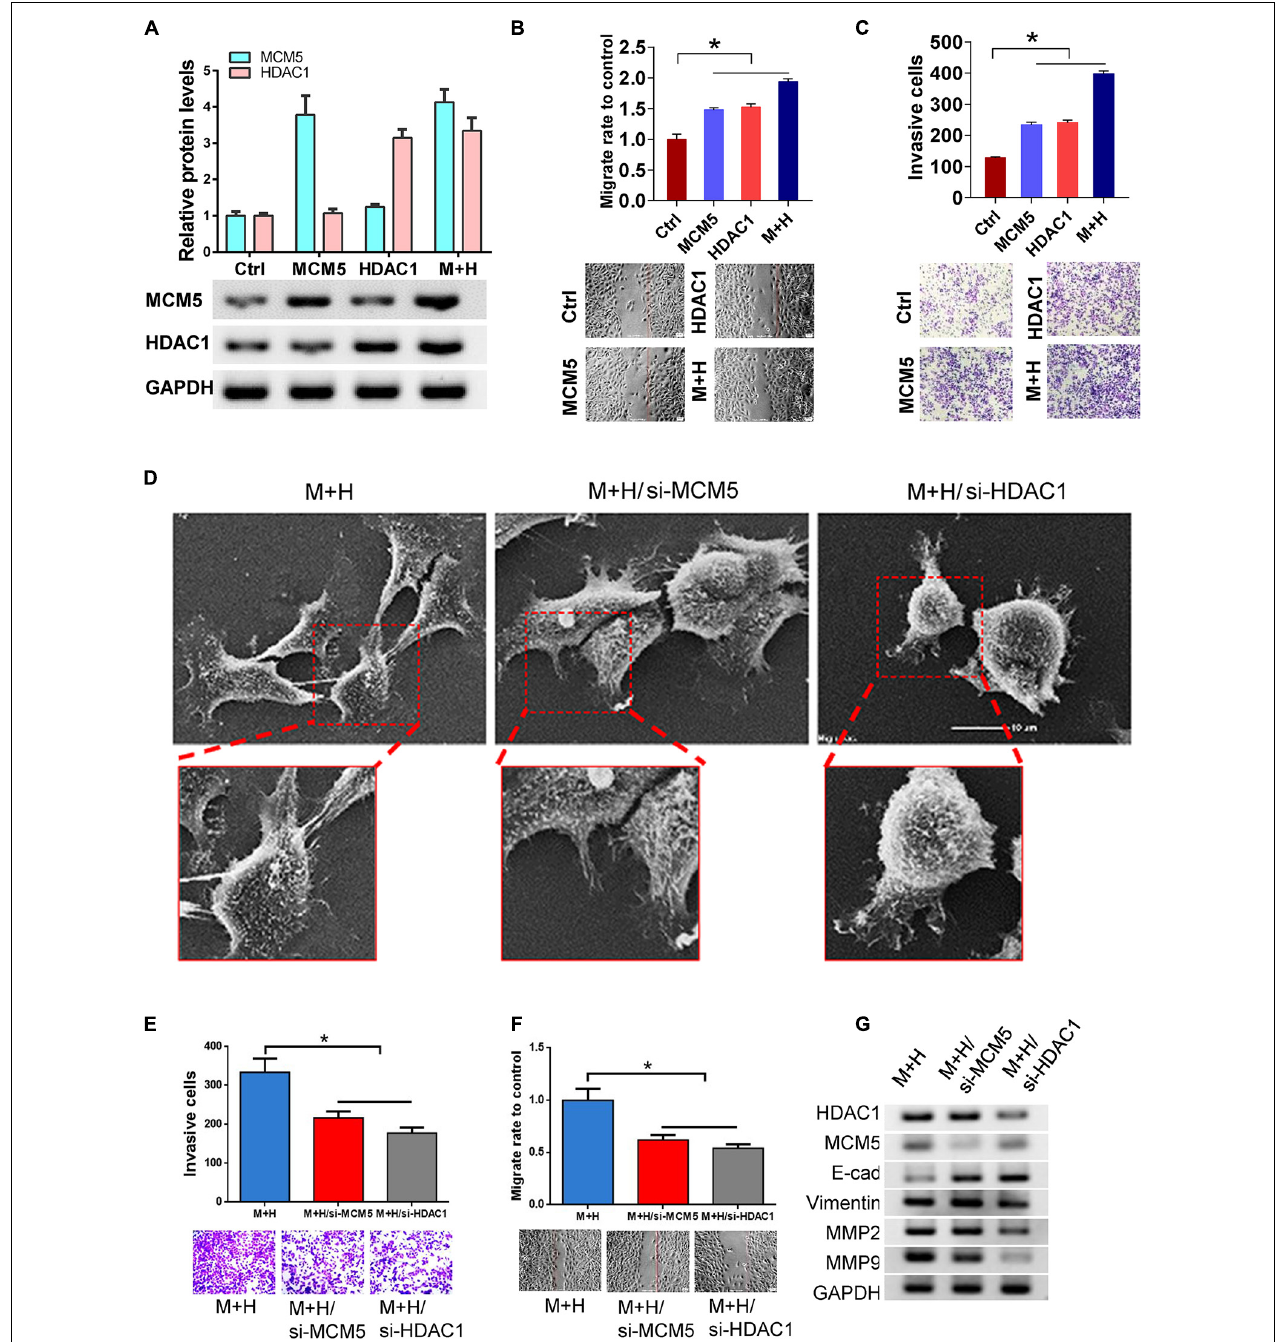
FIGURE 4 | MCM5/HDAC1 complex promoted lung cancer migration and invasion. After MCM5 and HDAC1 were expressed separately or co-expressed in H1975 cells, the cell function and the expression changes of EMT-related markers were detected. (A) Western blot analysis of HDAC1 and MCM5 expression. (B,C) The invasion and migration of H1975 cells after HDAC1 and MCMM5 expression. (D) Morphological changes in MCM5/HDAC1 overexpression H1975 cells after transfection with siMCM5 or siHDAC1 as observed by SEM. (E,F) Results of the invasion and migration of H1975 cells under different treatments. (G) Western blots of H1975 cells of E-cadherin, anti-Vimentin, anti-MMP2, and anti-MMP9 under different treatments. * P < 0.05.